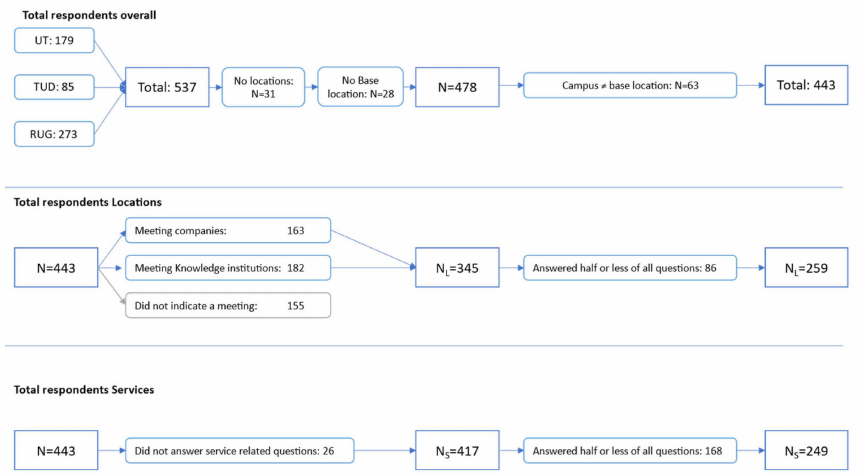
Figure 2. Flowchart cleaning